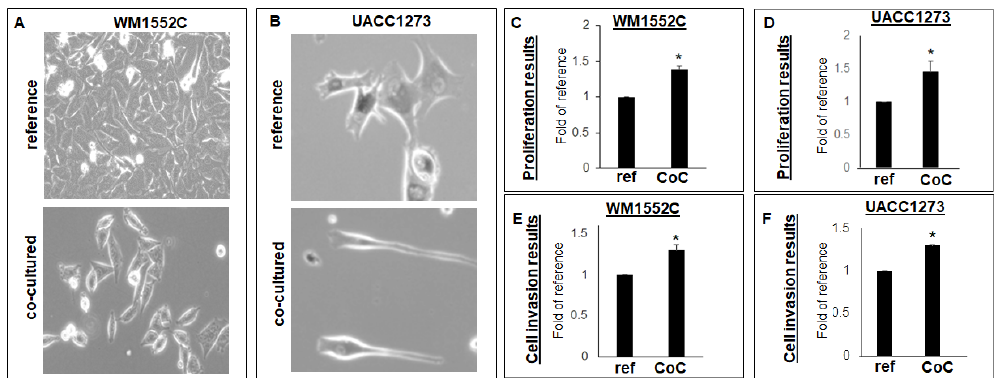
Figure 1. Morphologic and functional changes in poorly aggressive melanoma cells exposed to normal skin cells. Poorly aggressive, human melanoma cell lines WM1552C (( A ), 10× original magnification) and UACC1273 (( B ), 20× original magnification) show morphologic change from the native, epithelioid aspect (reference) to mesenchyme-like after co-culture with normal human skin cells (co-cultured). Results from MTT assay show increased metabolic activity in WM1552C ( C ) and UACC1273 ( D ) after co-culture with normal human skin cells compared to reference cells (ref). Results from cell invasion assay show increased invasiveness of WM1552C ( E ) and UACC1273 ( F ) after co-culture with normal human skin cells compared to reference cells (ref) (* p < 0.05). Assay results are representative of at least three independent experiments, each performed in quadruplicate.